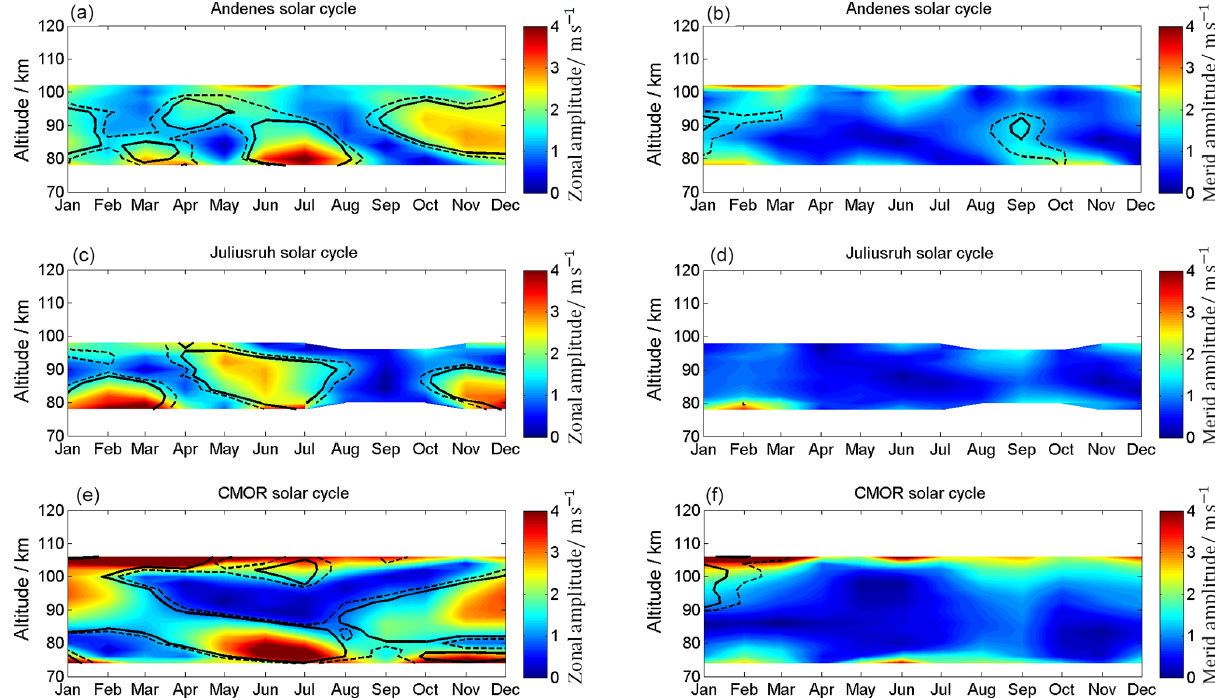
Figure 18. Linear change in the solar radiation on the zonal (a, c, e) and meridional (b, d, f) wind for Andenes (a, b) , Juliusruh (c, d) , and CMOR (e, f) . The solid black lines correspond to 95% significance, the dashed black lines to the 90% significance.